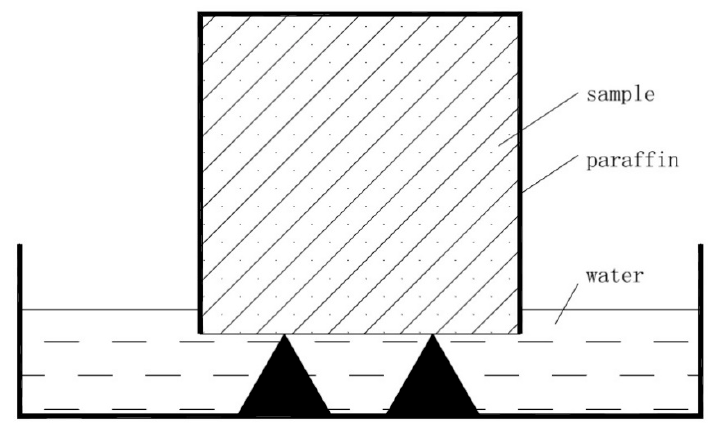
Figure 1. Schematic diagram of capillary water absorption test.